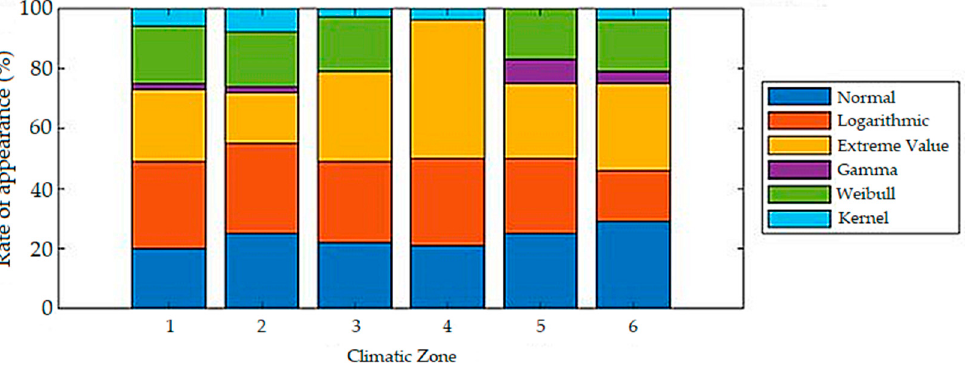
Figure 11. Bar chart with the rate of appearance of the PDFs in each month per climatic zone (GHI case). Source: own elaboration.